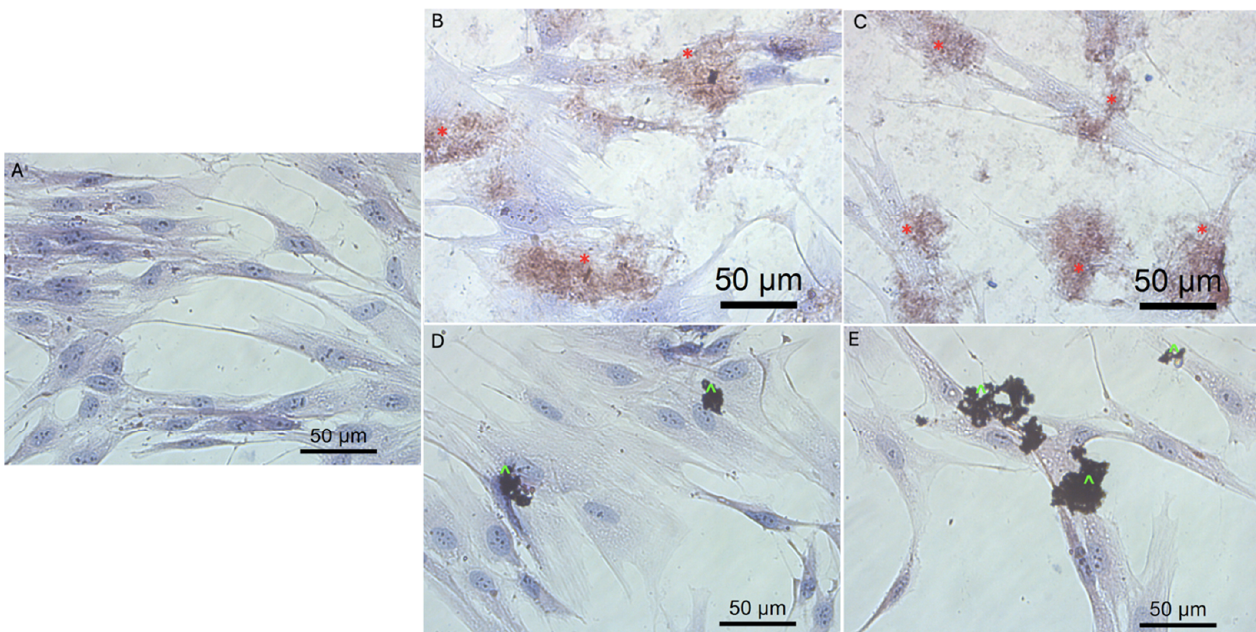
Figure 8. Morphology of T98 glioblastoma cells. ( A ) untreated cells (control group), cells treated with graphene oxide at concentration: 5 µg/mL ( B ), 100 µg/mL ( C ), and reduced graphene oxide at concentration: 5 µg/mL ( D ) and 100 µg/mL ( E ). Red * GO at cell membrane. Green ^ rGO at cell membrane. Light optical microscopy. Scale bars: 50 µm. ( A – E ). Ab- breviations: GO: graphene oxide, rGO: reduced graphene oxide.